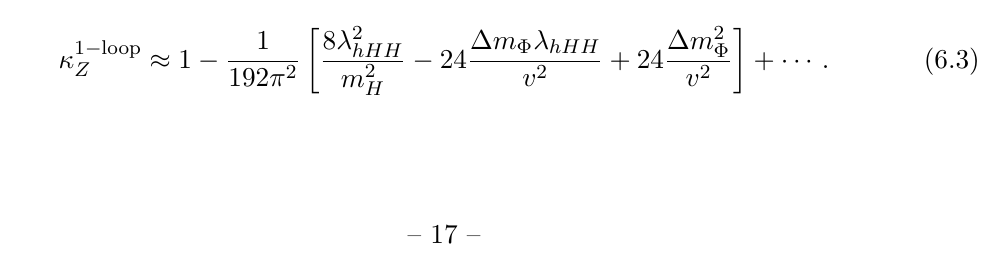
Figure 8 . Allowed region from three-parameter (cid:12)tting results at 95% C.L. in the (cid:1) m (cid:8) plane with varying m H under CEPC precision. Here cos( (cid:12) m H and lower two panels, (cid:1) m (cid:8) = m A (cid:1) m (cid:8) = m A=H (cid:6) (cid:0) 300 GeV (right panels). Shaded colored regions are used to indicate theoretical preferred